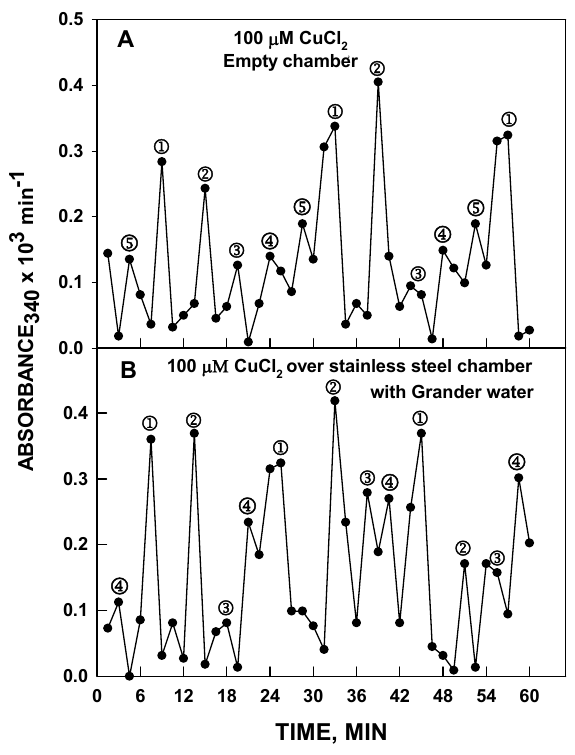
Figure 14. The metal need not be copper, and neither does the container need to be in the form of a coil. Identical results were obtained with a water filled chamber of stainless steel. ( A ) 120 µM NADH prepared in 100 µM CuCl 2 yielded the 5 peak 24 min period characteristic of CuCl 2 ; ( B ) With the CuCl 2 solution placed over the stainless steel chamber containing Grander or HPLC water, the CuCl 2 solution now oscillated with the 4 peak pattern and 18 min period typical of